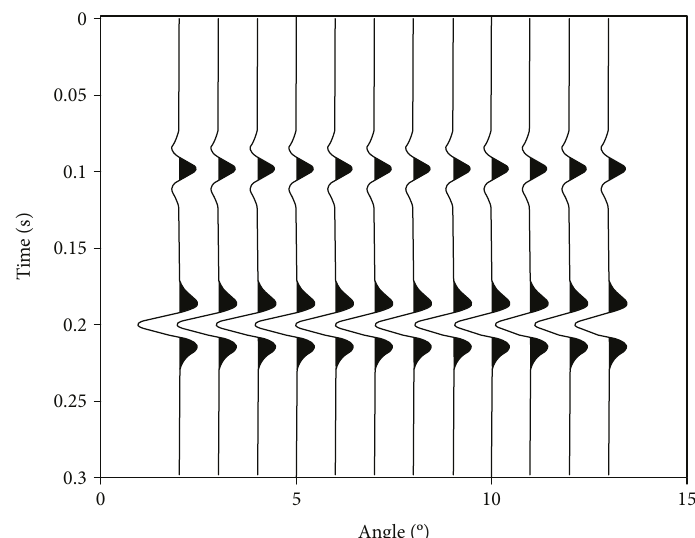
Figure 2: The prestacked synthetics at di ff erent incidence angles for layered medium model. The peak at 0.1s coincides with the interface across the top two elastic nonreservoir layers. The trough at 0.2s coincides with the interface between the elastic nonreservoir and poroelastic gas-reservoir